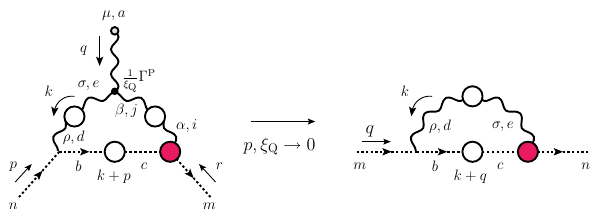
Fig. 2 The unique contribution to the ( (cid:2) b ) diagram of Fig. 1 which is non-vanishing in the p → 0 limit